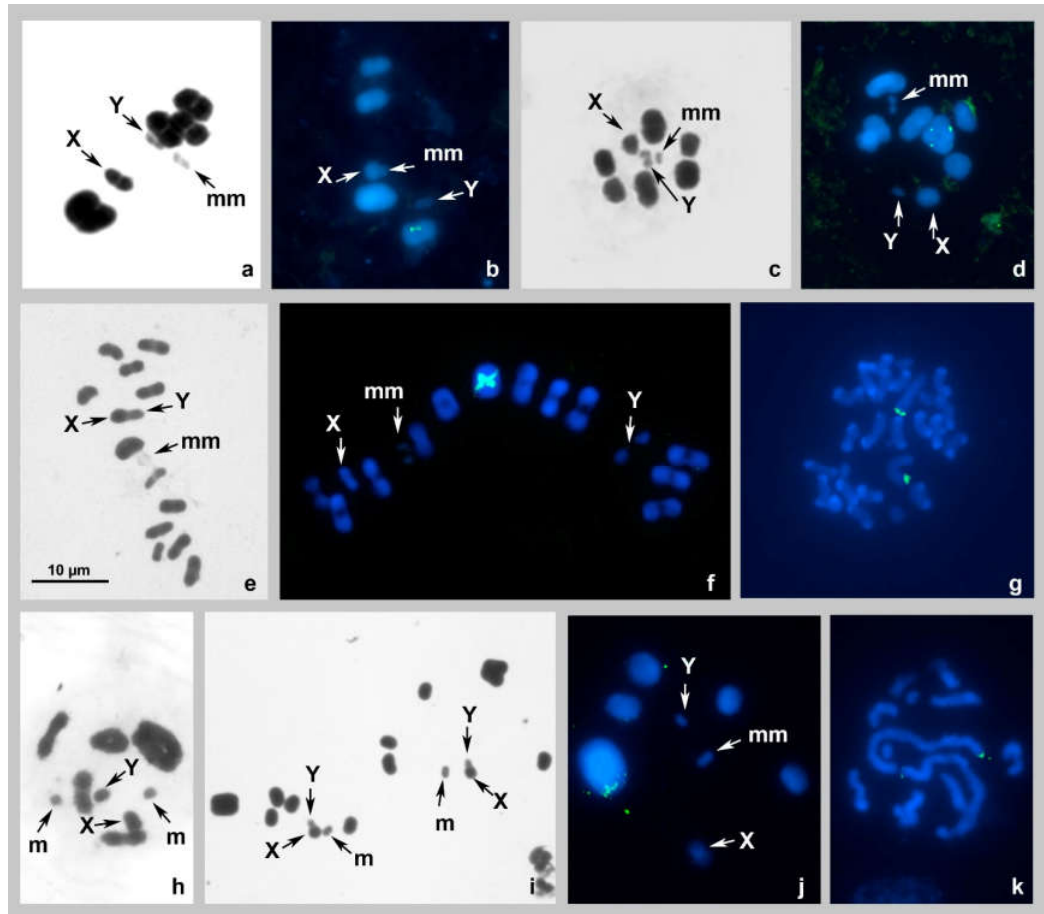
Figure 1. ( a – k ). Karyotypes of species of the families Rhyparochromidae ( a , b ), Heterogastridae ( c , d ), Cymidae ( e – g ), and Blissidae ( h – k ) after Schiff–Giemsa and double-target FISH with 18S rDNA and telomeric (TTAGG) n probes. ( a , b ) Elasmolomus squalidus MI standard staining ( a ), MI FISH ( b ); ( c ) Nerthus sp. 1 MI standard staining; ( d ) Nerthus sp. 2 MI FISH; ( e – g ) Cymus claviculus MI standard staining ( e ), MI FISH ( f ) spermatogonial metaphase FISH ( g ); ( h – k ) Dimorphopterus spinolae late diakinesis standard staining ( h ), MII standard staining ( i ), MI FISH ( j ), and spermat- ogonial metaphase FISH ( k ). 18S rDNA signals are green; TTAGG signals are absent. Bar = 10 µm